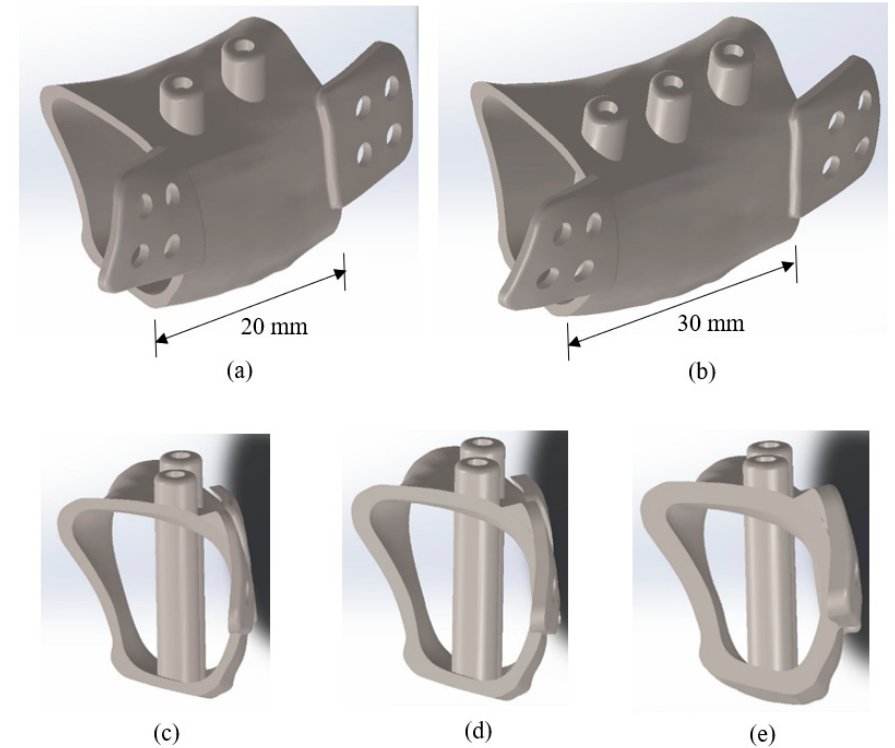
Figure 3. Using Model 2 as an example: ( a ) implant body length of 20 mm; under this length, two abutments are allocated; ( b ) implant body length of 30 mm; under this length, three abutments are allocated; ( c ) implant body thickness of 0.8 mm; ( d ) implant body thickness of 1.0 mm; and ( e ) implant body thickness of 1.5 mm.